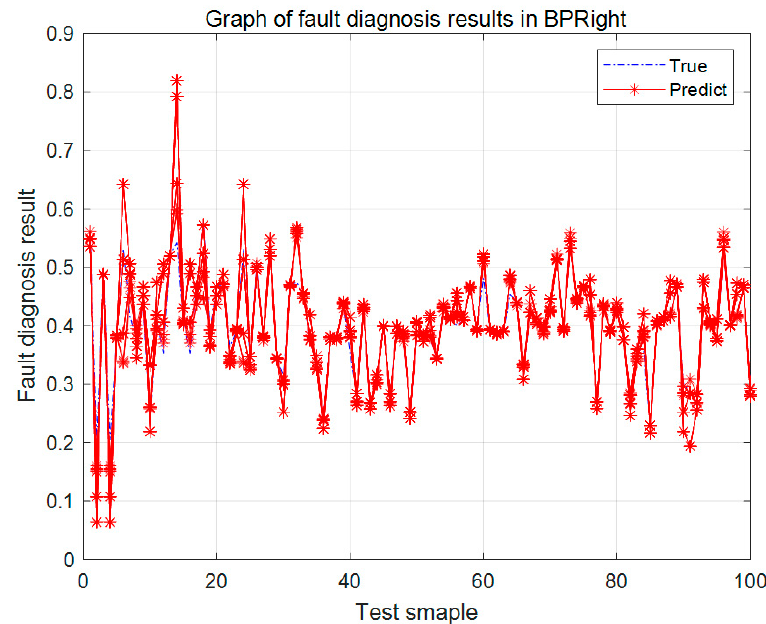
Figure 12. Fitting diagram of experimental results by BP method. Figure 13 shows the diagnosis results obtained in ELM mode.